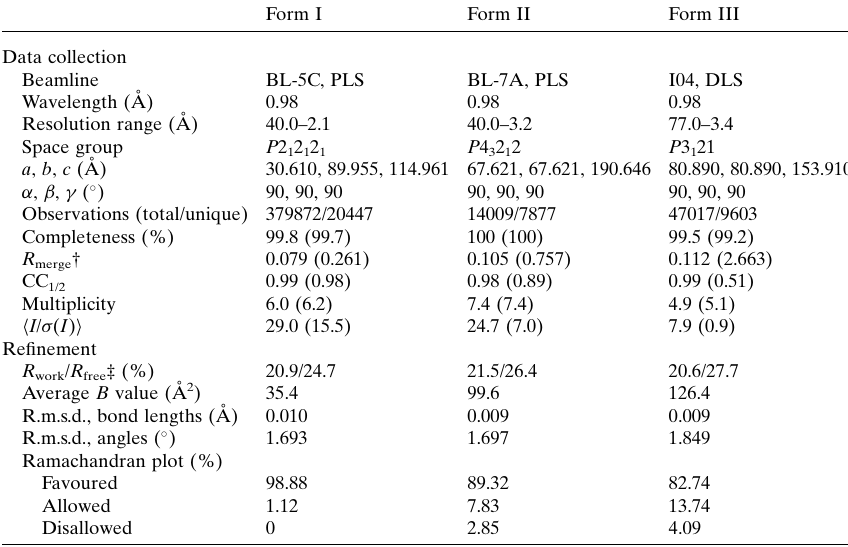
Table 1 Crystal data-collection and refinement statistics. Values in parentheses are for the highest resolution